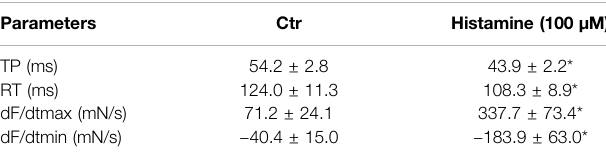
TABLE 1 | Contractile parameters (time to peak tension (TP), time of relaxation (RT), fi rst maximum positive or negative derivate of force development (dF/dt max or min)) in human right atrial preparations. Data are means ± SD from 8 preparations of 3